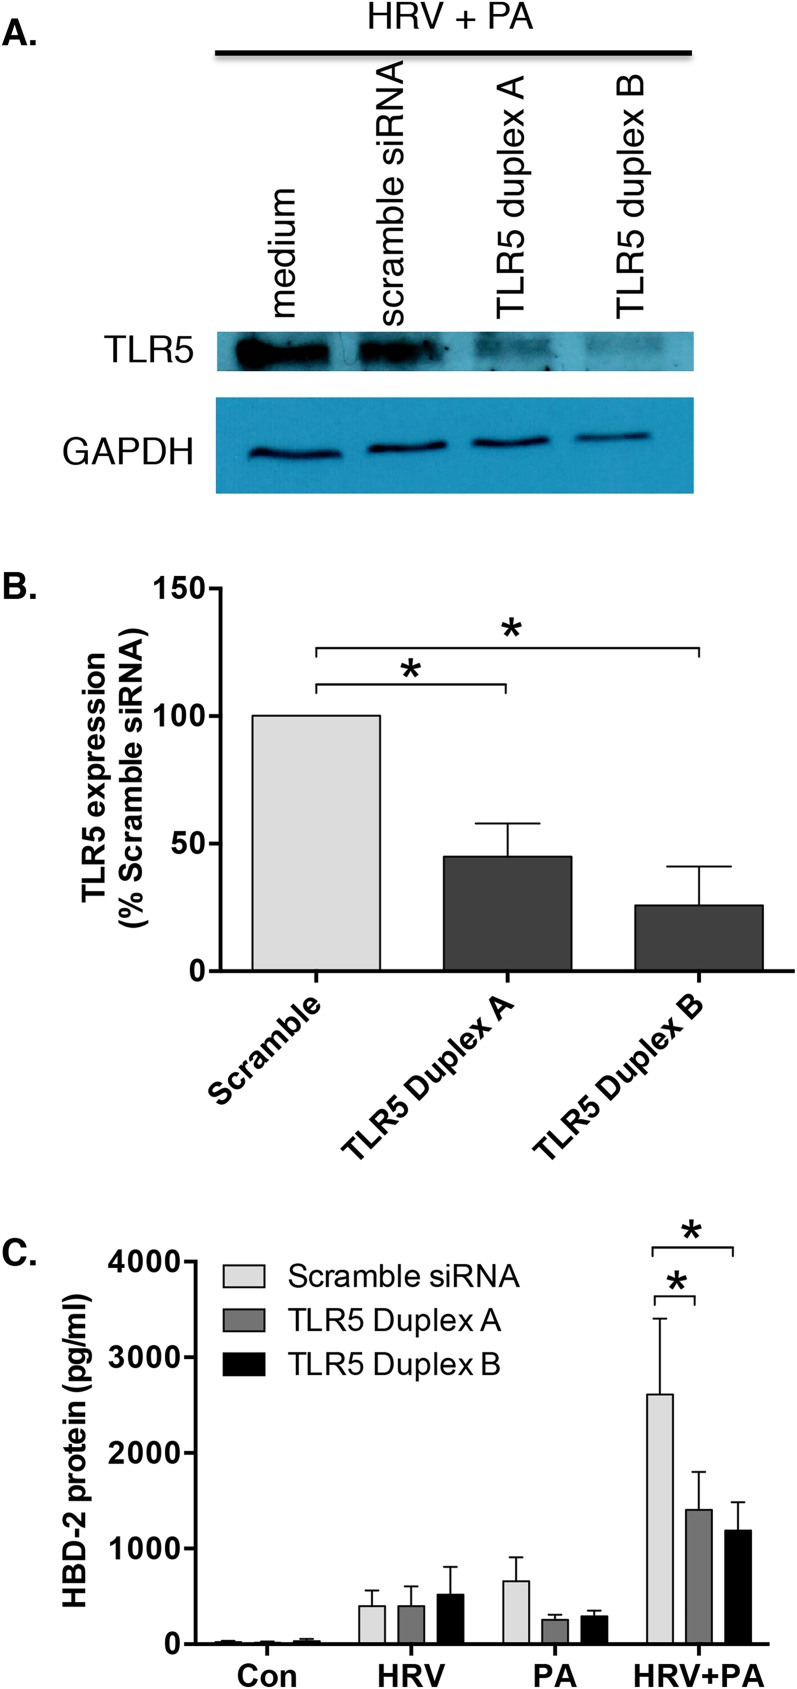
Human rhinovirus (HRV) and Pseudomonas aeruginosa (PA) induced human beta-defensin (HBD)-2 expression is reduced following the knockdown of toll-like receptor (TLR)-5.A) TLR5 protein levels in human bronchial epithelial (HBE) cell lysates (48 h after infection) induced following HRV/PA co-infection were assessed via western blotting following lipid-mediated transfection (24 h) of 10 nM TLR5 short-interfering RNA (siRNA) duplexes A or B, compared with non-targeting control siRNA. B) Densitometric analysis of TLR5 protein expression of HRV and PA co-infected HBE cells transfected with TLR5 siRNA duplex A or B, or control siRNA. TLR5 expression levels were normalized to GAPDH and compared to siRNA control. C) HBD-2 protein (n = 6) levels were determined following 48 h infection with HRV-16, PA, alone and in combination, all in the presence or absence of TLR5 siRNA duplex A or B. Data are expressed as mean ± SEM (*p<0.05).